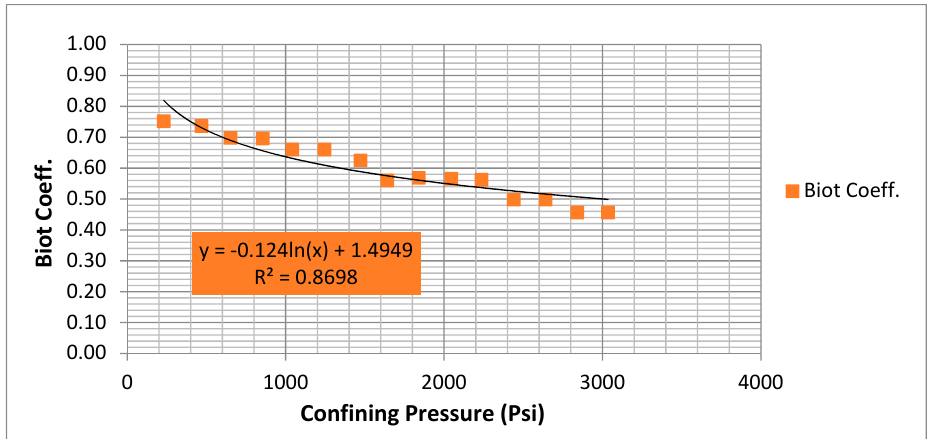
Figure 14. Undrained and drained dynamic bulk moduli vs. confining pressure for H4.